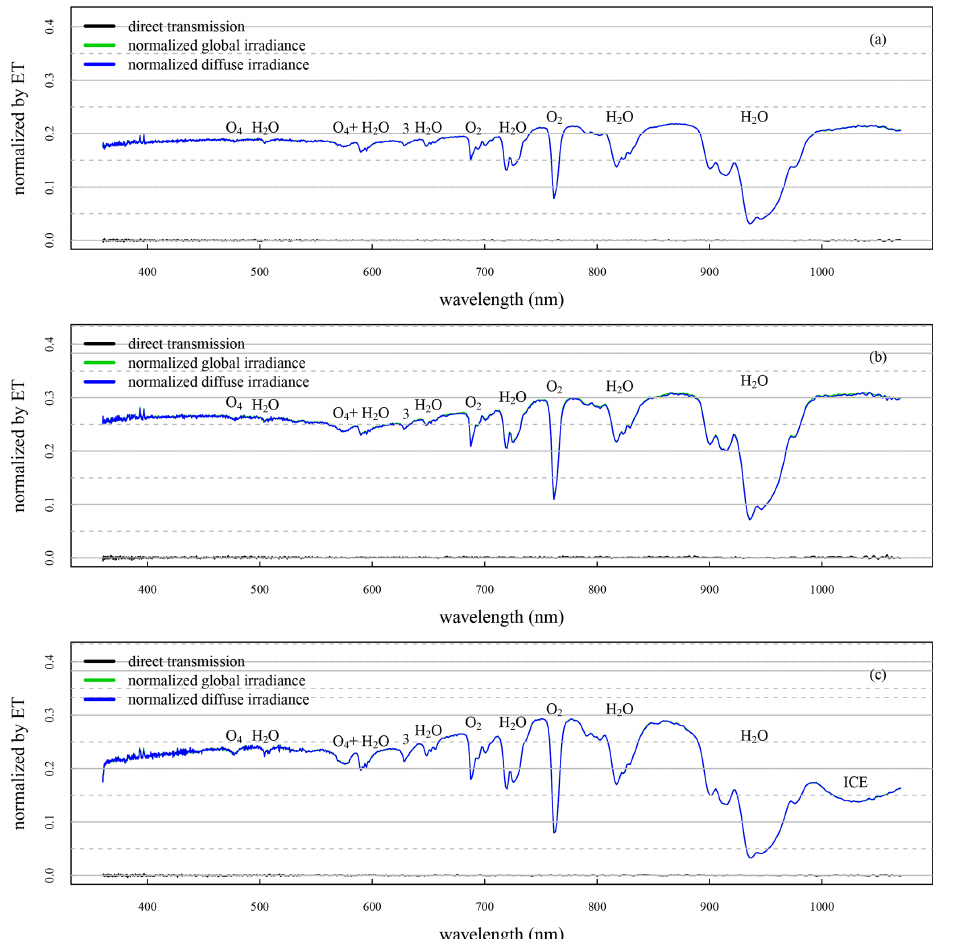
Figure 9. (a) A spectrally continuous transmission spectrum for a totally overcast sky on 25 October 2009 at the northern Oklahoma ARM site. Outside the molecular bands, there is an overall monotonic increase in transmission with wavelength. The band (identified by the number 3) near 630nm includes overlapping H 2 O, O 2 , and O 4 bands. The bands labeled O 4 + H 2 O are overlapping bands. H 2 O near 505nm is identified as a weak water band in the HITRAN (high-resolution transmission molecular absorption) database. Panel (b) is a similar plot to panel (a) but for overcast skies on 24 October 2009, with a higher overall normalized global/diffuse irradiance. Note the same details for the absorption features, except for the more pronounced Chappuis ozone band centered near 600nm. Panel (c) is a spectral irradiance plot for an overcast day (24 December 2009), with ice clouds present as identified from the ARM radar measurements. Note the pronounced difference in the spectrum beyond 1000nm, compared to panels (a) and (b) , indicated by the ICE label between 1000 and